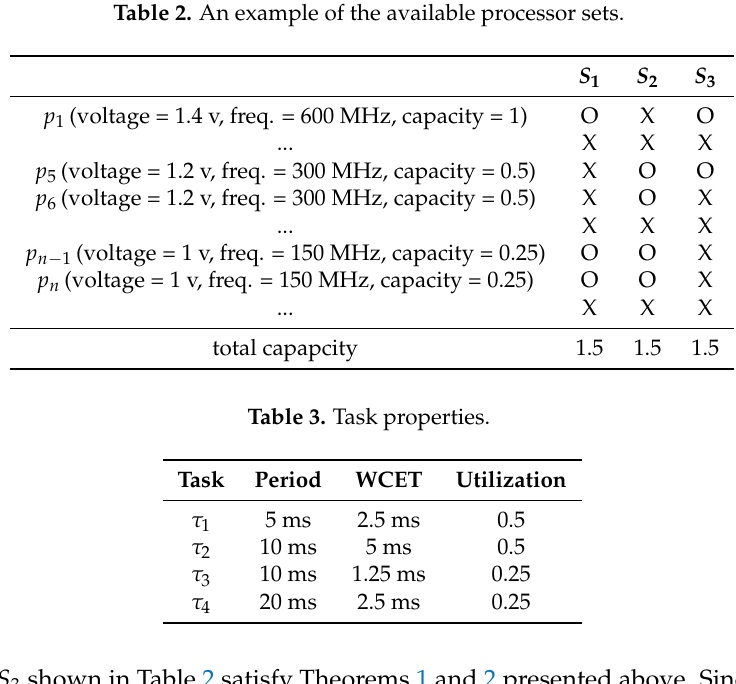
Table 2. An example of the available processor sets.